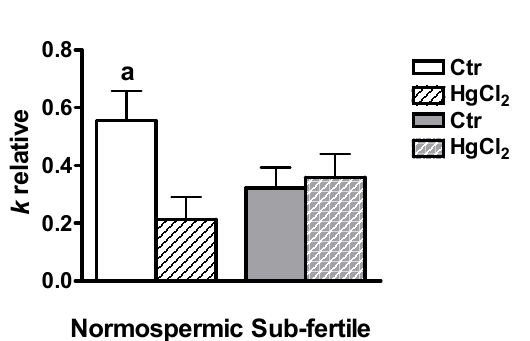
Figure 5. Effect of mercury chloride (HgCl 2 ) treatment on the hydrogen peroxide permeability of human ejaculated semen from normospermic and sub-fertile subjects. Hydrogen peroxide permeability was measured by loading the human ejaculated semen with CM-H2DCFDA reagent and incubating with 50 µ M H 2 O 2 as described in Materials and methods. Bars represent the H 2 O 2 permeability of sperm cells expressed as k relative. Values are mean ± SEM of two time courses for each of eight different experiments. a, p < 0.05 vs. Ctr sub-fertile, HgCl 2 normospermic, HgCl 2 sub-fertile (ANOVA, followed by Dunnett t test test). Ctr, controls.